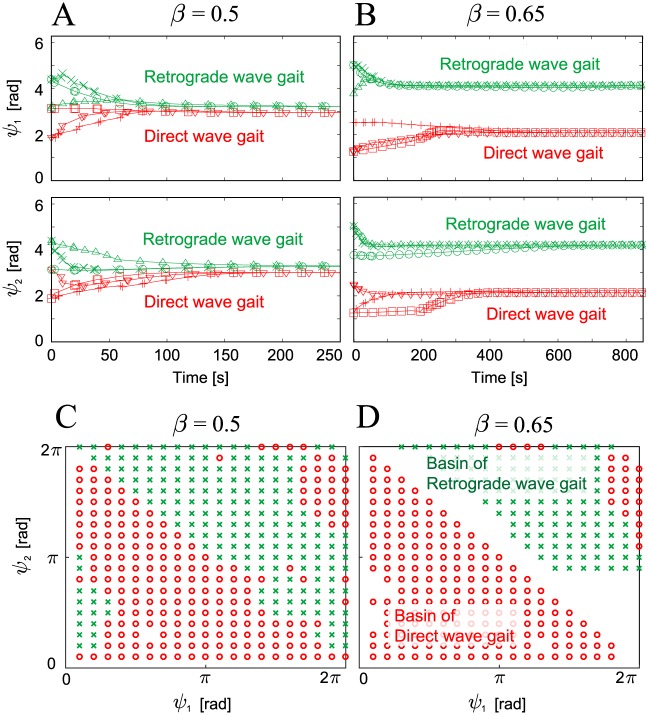
Relative phases (ψ1, ψ2) of the robot simulation plotted at the foot contact of Leg 2 and the basins of attraction.Relative phases are plotted for six initial conditions with (A) β = 0.5 and (B) β = 0.65. Six different markers represent the results for the six initial conditions. Irrespective of β, the robot established two different gaits (i.e., direct and retrograde wave gaits) that were dependent on the initial conditions. The basins of attraction for the two different gaits are plotted for (C) β = 0.5 and (D) β = 0.65. The red circles and green x points in (C) and (D) converge to the direct wave gaits and the retrograde wave gaits, respectively. The direct wave gaits have larger size of basins than the retrograde wave gait.